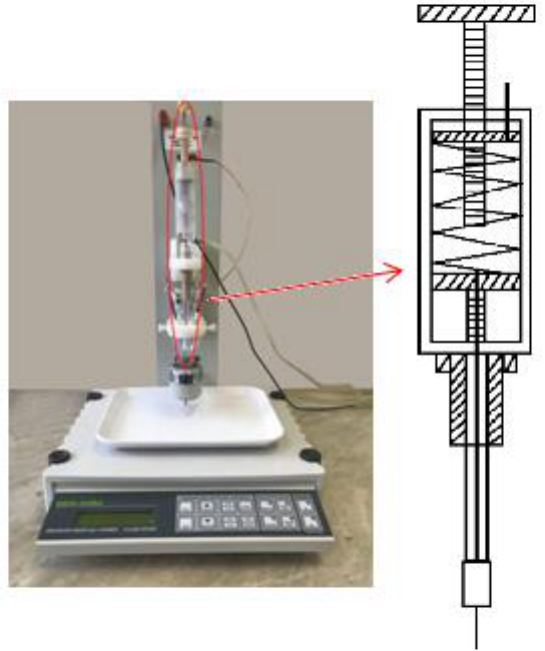
Figure 9. Three-electrode voltammetric cell on the automatic stand with the centrally fixed working electrode (R – AgLAFE).